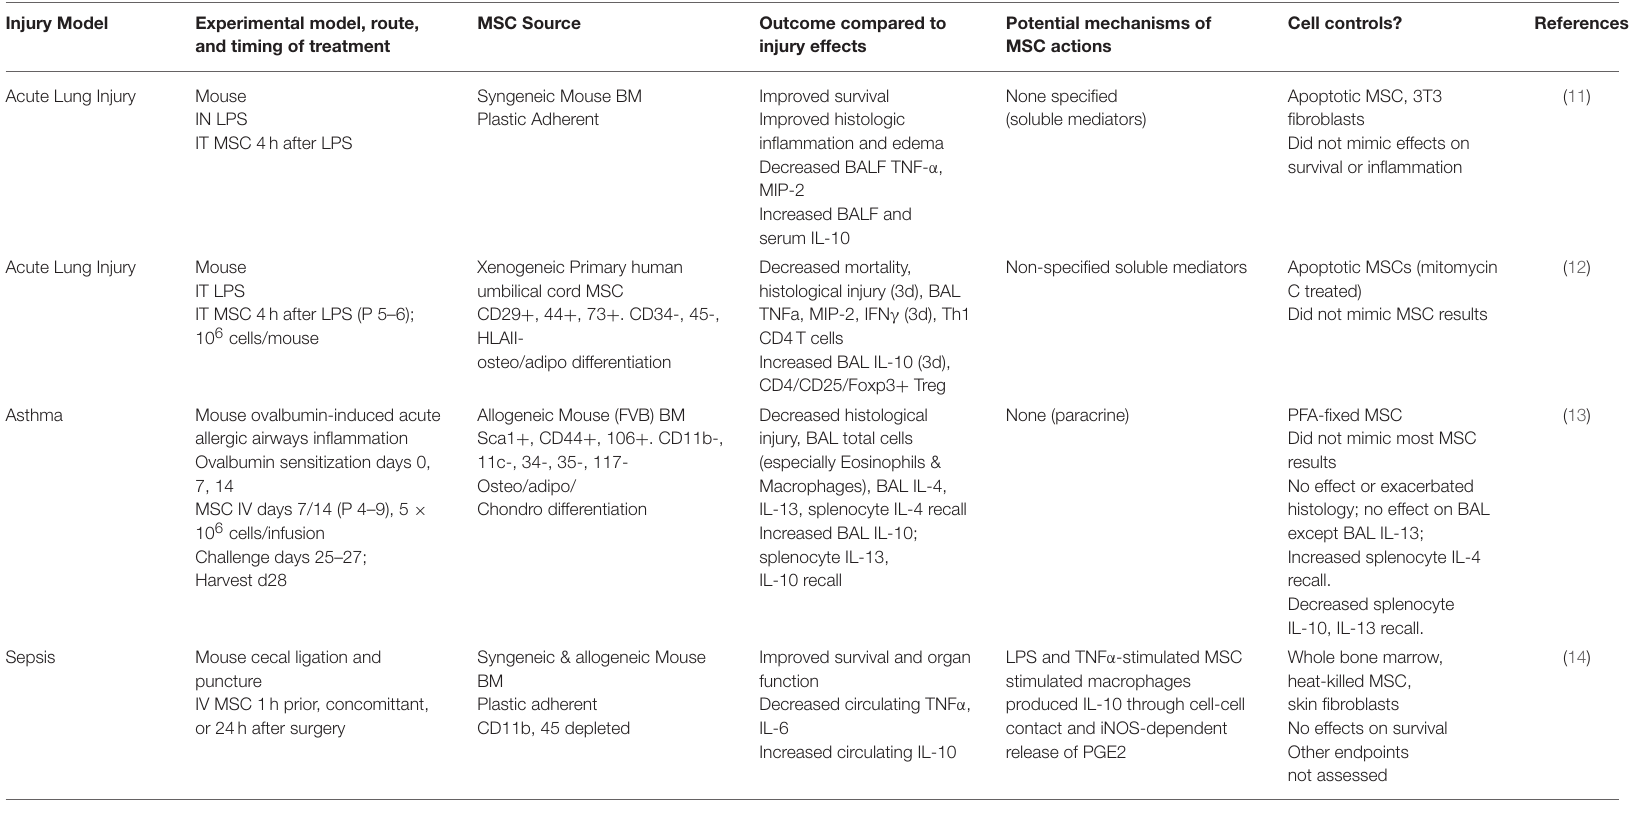
TABLE 1 | Pre-clinical lung injury studies utilizing dead or apoptotic